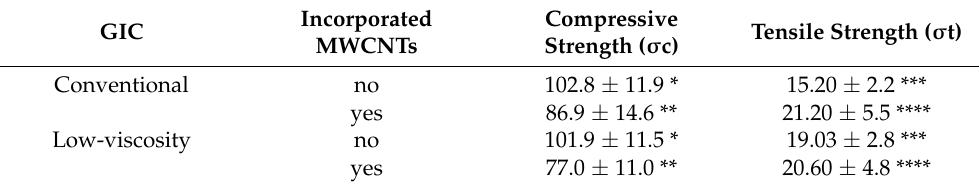
Table 2. Mean values (MPa) and standard deviations obtained for the compressive strength test and the diametral tensile strength test for the evaluated conditions.